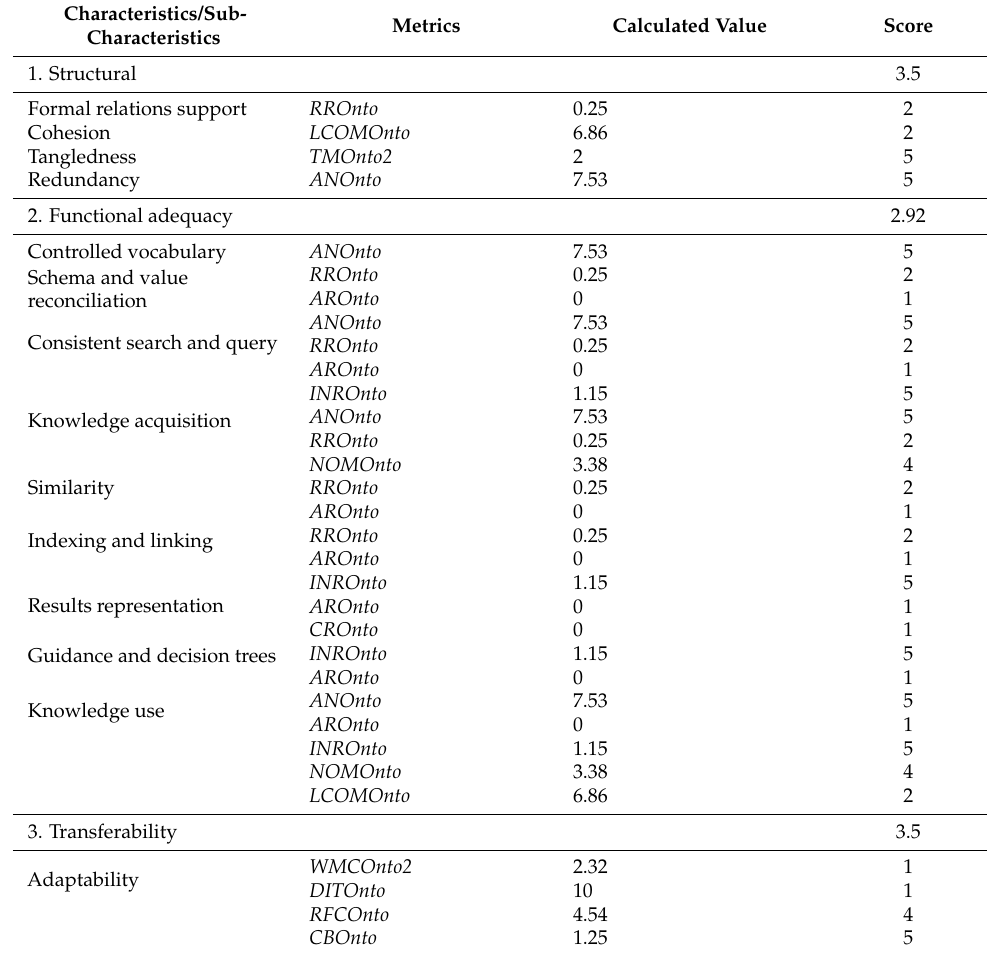
Table 5. Evaluation results for the CIDOC CRM obtained from the corrected OQuaRE